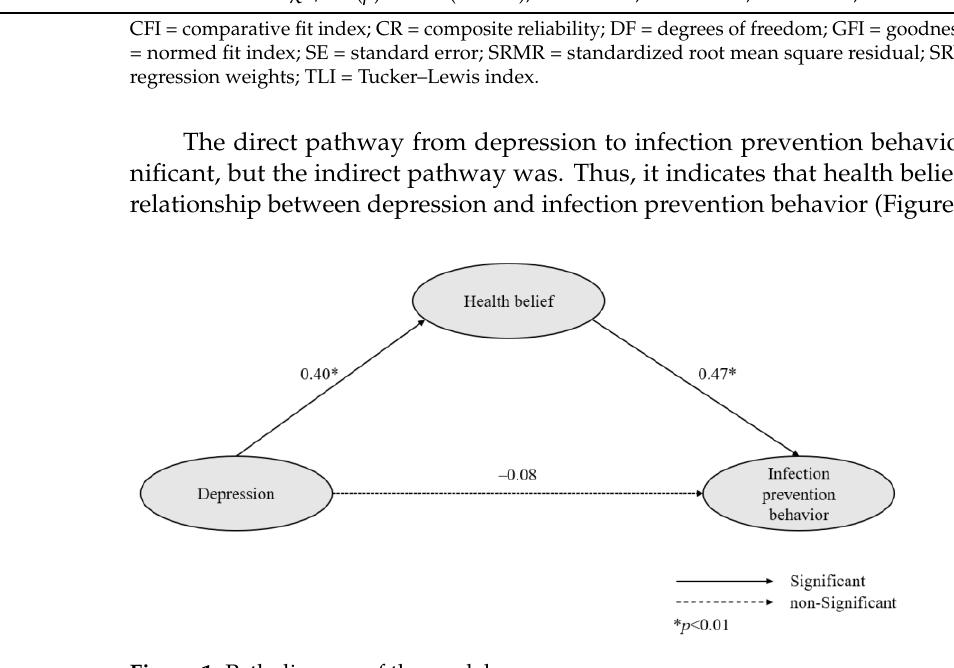
Figure 1. Path diagram of the